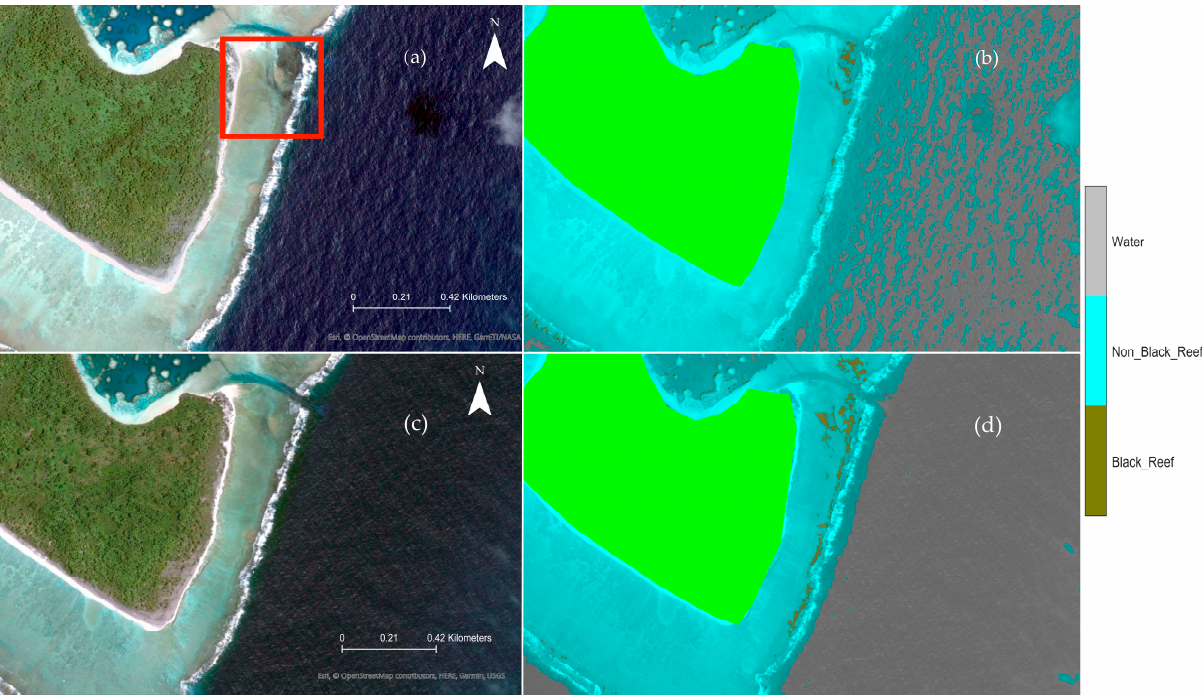
Figure 10. ( a ) Google Earth imagery from year 2004 (Google Earth Pro, 2004, 2011) and ( b ) the segmented image. The light green colour indicates subaerial vegetation mask based on Landsat imagery, while the red rectangle indicated the area where the shipwreck is located [18]. The segmented image shows the appearance of a black reef near the entrance of the lagoon. ( c ) Google Earth image taken in 2011 while in ( d ) is the final segmented image. From the segmented image is clear that the black reef has extended to the other site of the lagoon’s entrance as well as across the coastal area.